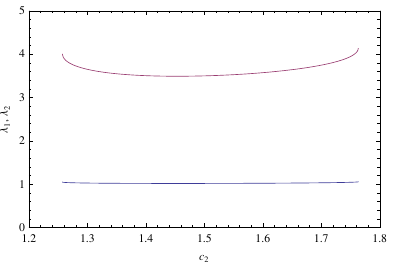
Figure 3. Plot of the eigenvalues λ 1 and λ 2 of the matrix M for algebraically stable TSRK methods (4.4) with p = q = s = 2.